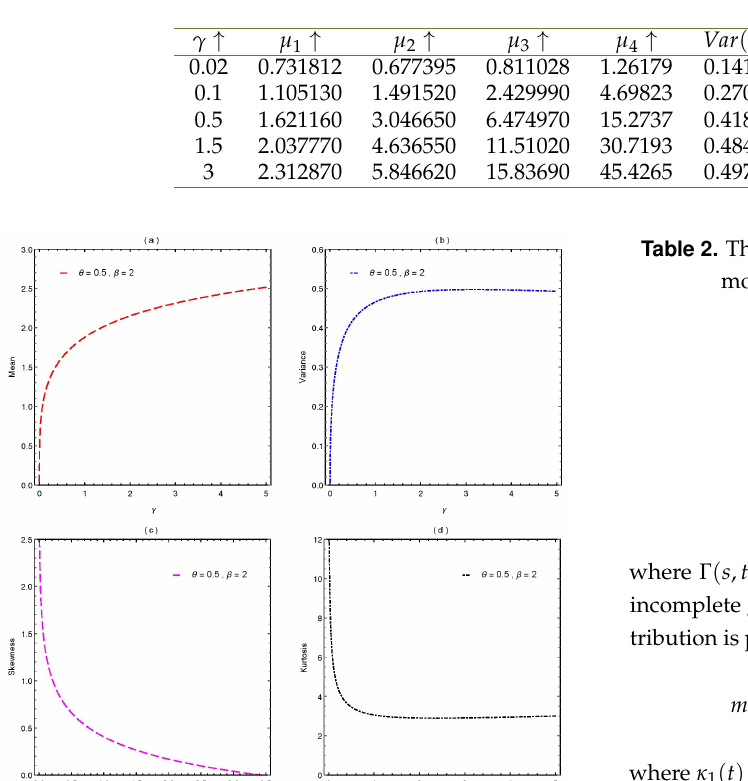
Table 1. The values of first four moments, Var, Sk and Kur of MOPA model with ( β = 2, θ = 0.5).